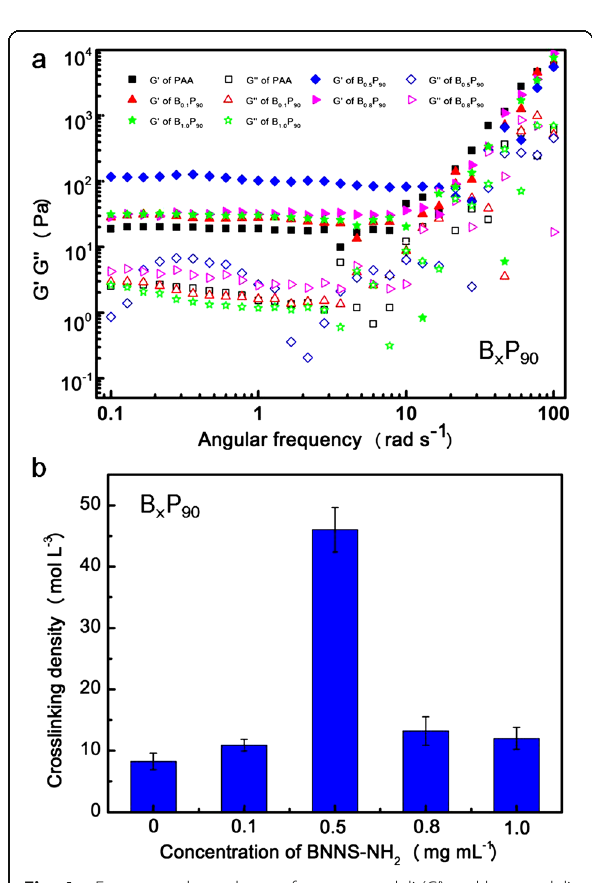
Fig. 4 a Frequency dependence of storage moduli (G ’ ) and loss moduli (G ” ) of B x P 90 at a strain of 0.1%. b Crosslinking density of B x P 90 calculated by equilibrium shear